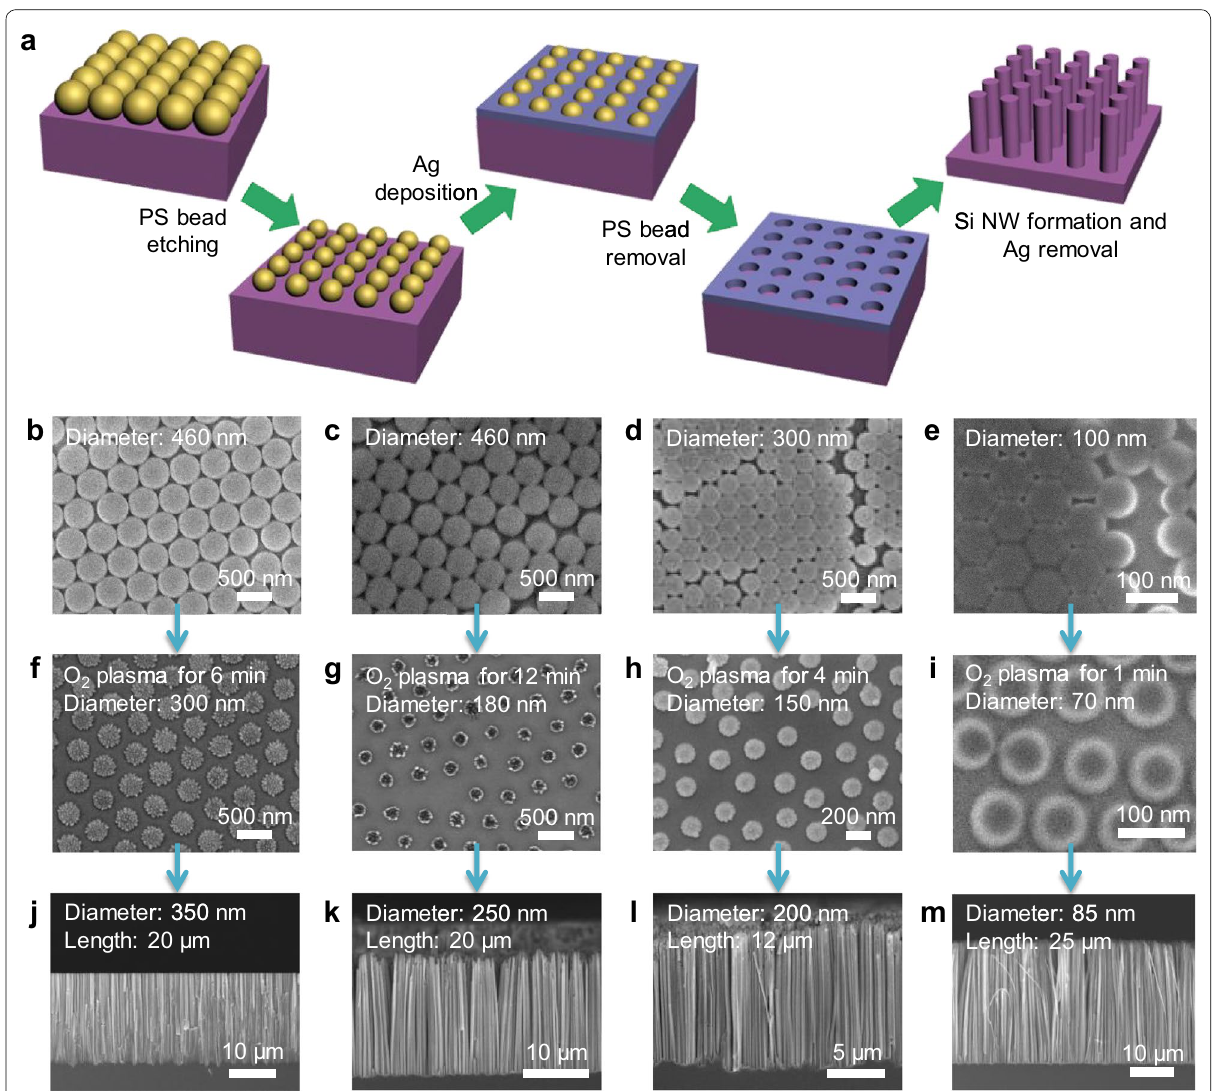
Fig. 2 a Schematic illustration of the preparation of a Si NW array using a Ag film with uniform‑sized holes as an etch mask, where PS beads were used for patterning the Ag film. b – m FESEM images of the process steps for fabricating vertically aligned, ordered Si NW arrays